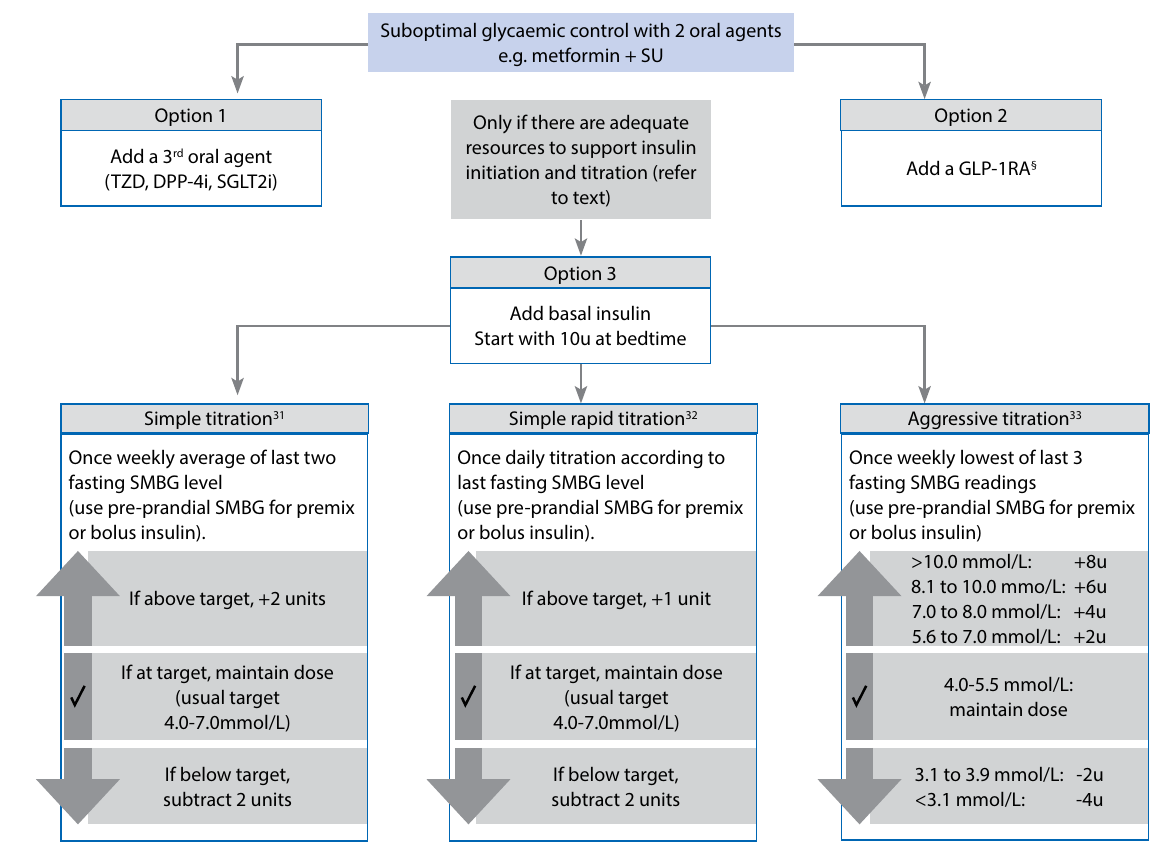
Figure IV: Initiating and titrating basal insulin therapy